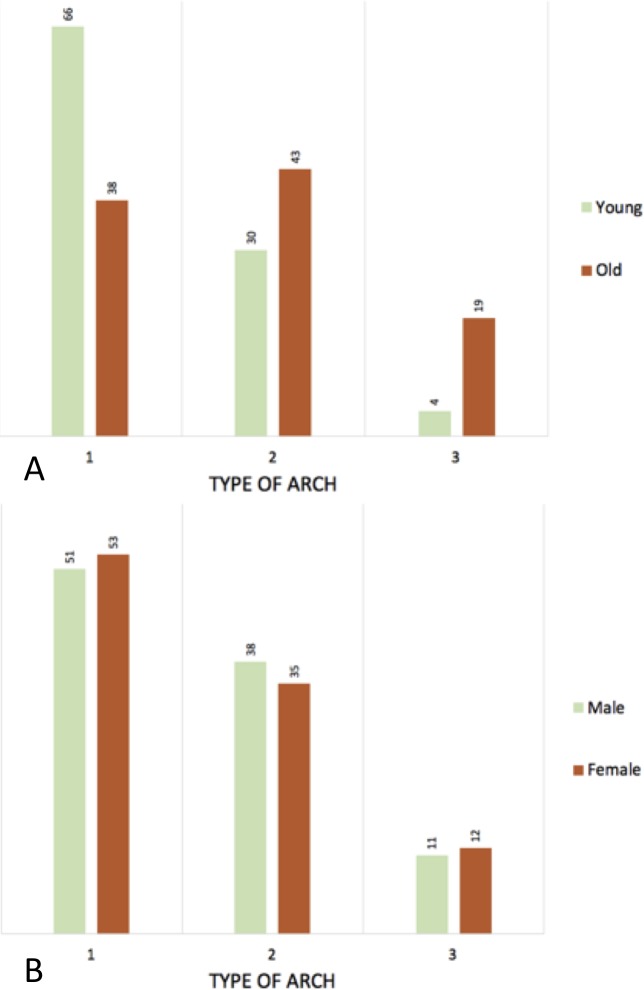
Histogram of the type of arch.A: young vs. old; B: male vs. female.